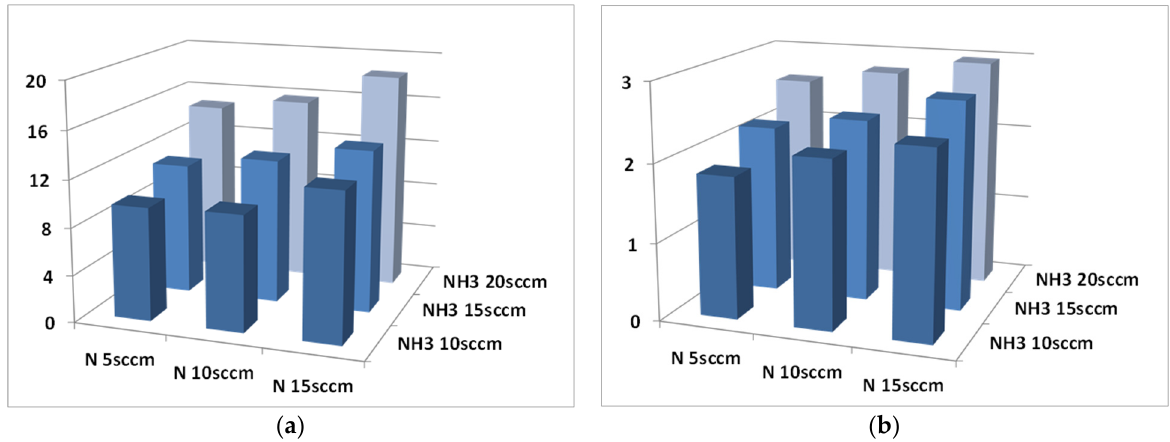
Figure 4. ( a ) Trend of the total N 1s abundance (in %) as a function of the increasing N 2 and NH 3 flow rates in the plasma process. ( b ) Trend of the amino-N fraction as a function of the N 2 and NH 3 flow rates.